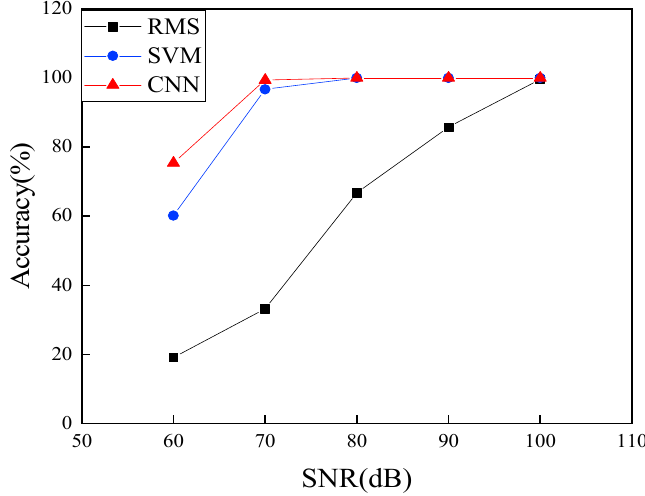
Figure 28. Comparison of the proposed damage detection with other two methods in accuracy.